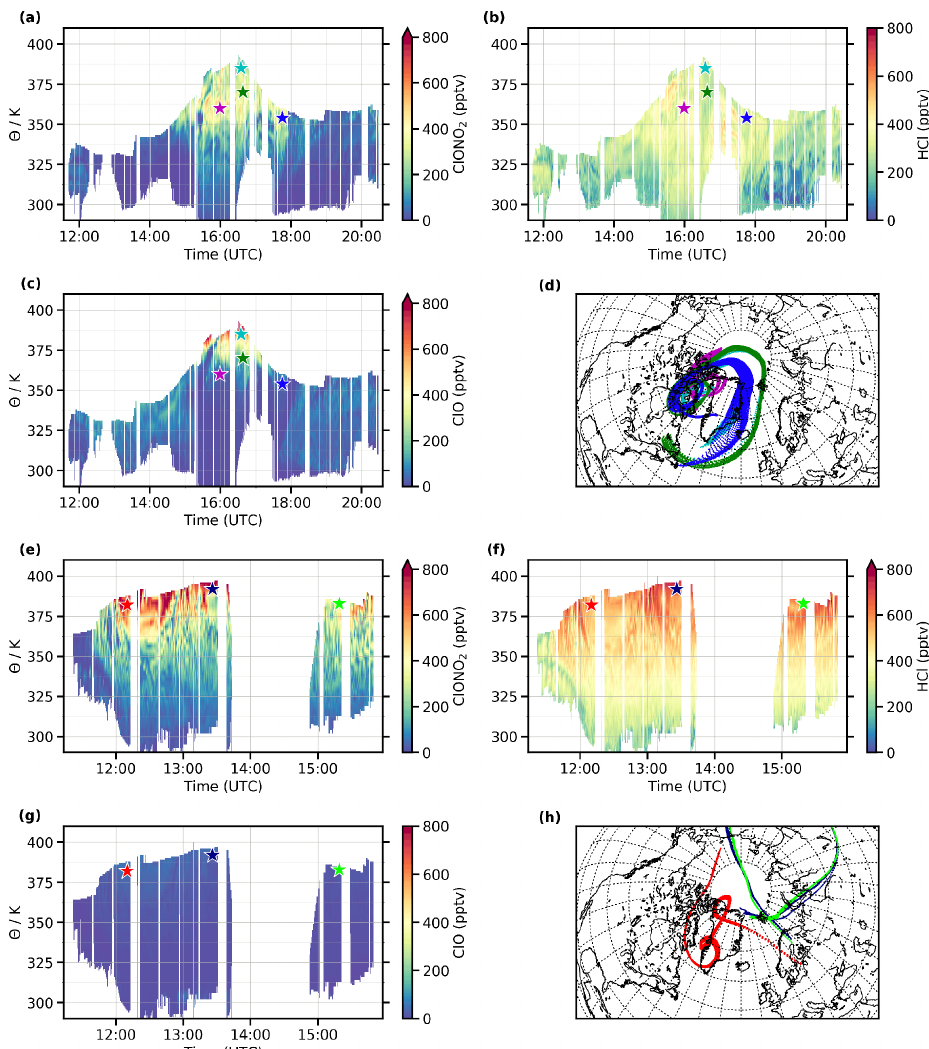
Figure 11. Cross sections for (a, e) ClONO 2 , (b, f) HCl, and (c, g) ClO at the end of CLaMS trajectories leading to the GLORIA tangent point geolocations for flights PGS14 (a) – (d) and PGS21 (e) – (h) . Regions of interest are marked with colored star symbols. The 11d backward trajectories calculated for each flight by CLaMS are shown on the map (d, h) in corresponding colors. The underlain map (bold black lines show coastal lines, and dotted lines indicate a latitude by longitude grid) shows the northern polar region and is centered at 80 ◦ N latitude and 20 ◦ W